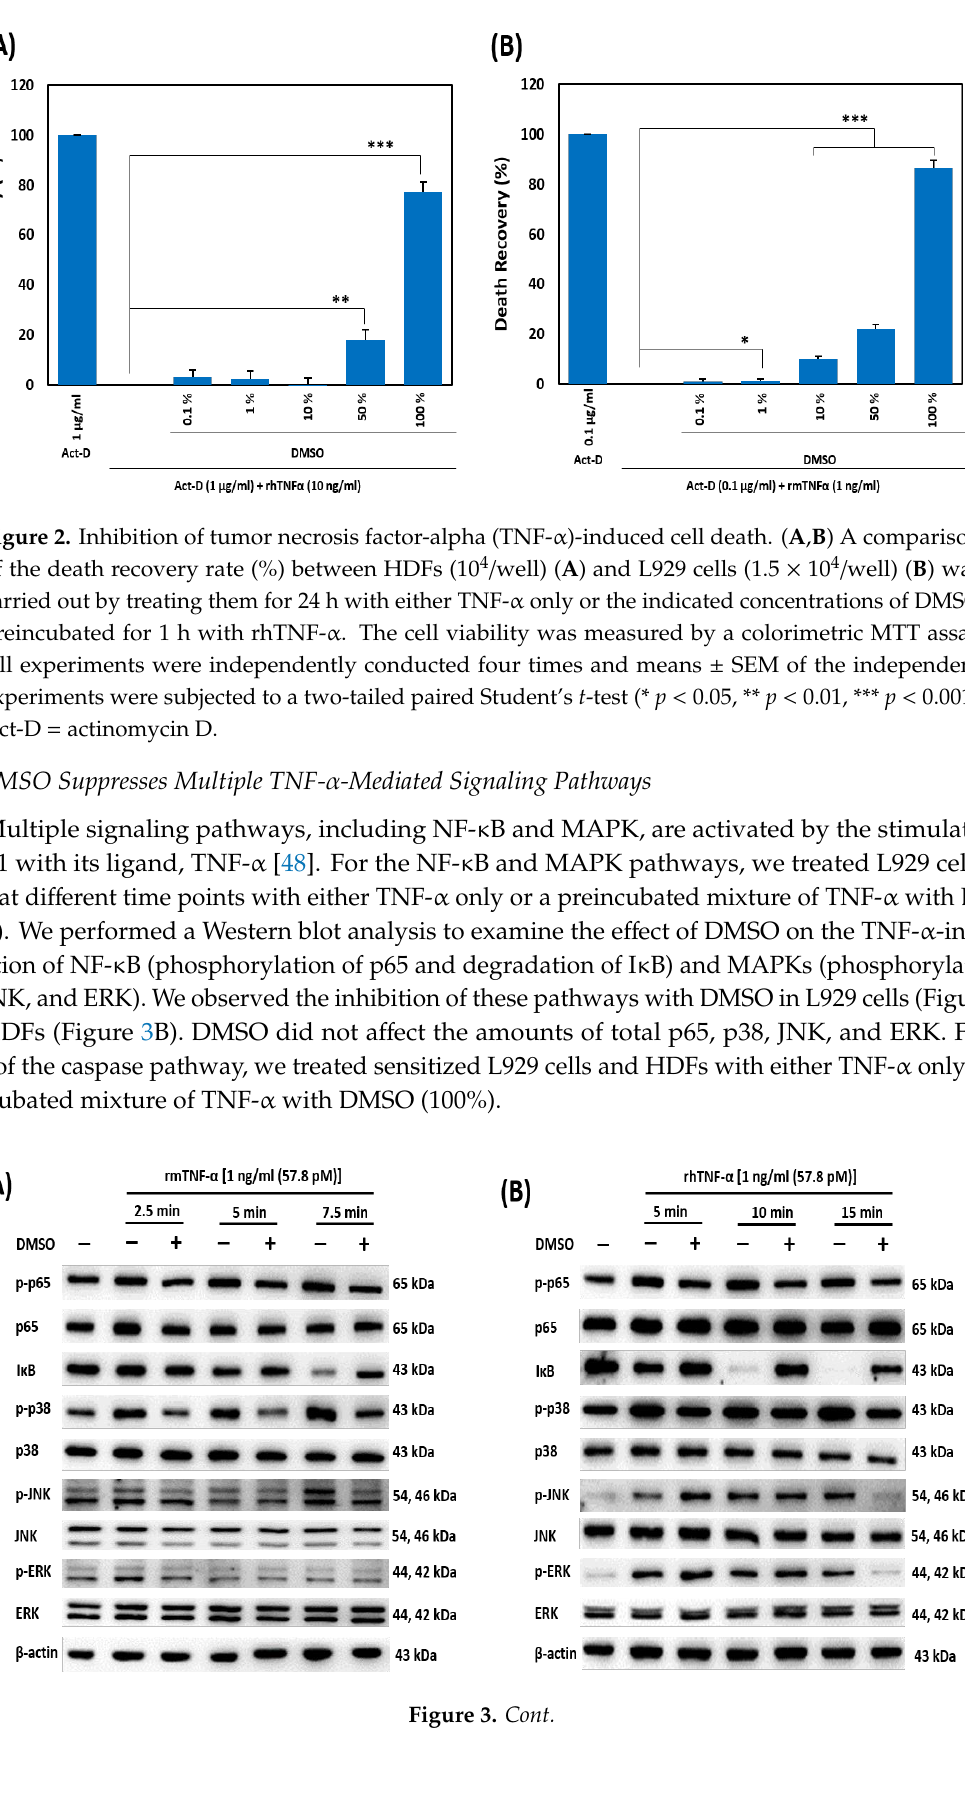
Figure 3. Inhibition of TNF-α-dependent signaling pathways by disruption of the oligomeric form. ( A , B ) The inhibition of NF-κB and MAPK-signaling pathways by DMSO (100%) was evaluated by treating L929 cells ( A ) and HDFs ( B ) at the indicated time points with either TNF-α only or DMSO preincubated for 1 h with rhTNF-α. ( C , D ) Disruption of homotrimerization of recombinant mouse TNF-α (rmTNF-  ( C )) and recombinant human TNF-α (rhTNF-  ( D )) after the treatment with DMSO was evaluated. Human and mouse TNF-α were incubated with DMSO, chemically cross-linked, and subjected to Western blotting. NC = non-cross-linked control (no cross-linker, no inhibitor); CC = cross-linked control (no inhibitor). The blots were visualized on a ChemiDoc™ Touch Imaging System (Bio-Rad Laboratories). 2.4. DMSO Prevents Oligomerization of TNF-α After we confirmed the inhibitory impact of DMSO on the TNF-α signaling pathway, the DMSO mechanism of action was evaluated in a protein cross-linking interaction assay with subsequent Western blot analyses. A perturbation in the homotrimeric form of TNF-α interferes with its functionality and causes the inhibition of cytokine secretion and cell death [37,49,50]. To this end, rhTNF-α and rmTNF-α were separately preincubated with DMSO, chemically cross-linked, and analyzed by Western blotting. As expected, DMSO inhibited the formation of functional homotrimers in both rmTNF-α (Figure 3C) and rhTNF-α (Figure 3D) in a concentration-dependent manner. In the case of rhTNF-α, we unexpectedly observed a stronger formation of the trimer at ≤10% DMSO, as compared with the cross-linked control (CC), and the same was the case for water only (H 2 O; Figure 3D). The mechanism underlying this species-specific action of water on TNF-α needs to be confirmed.